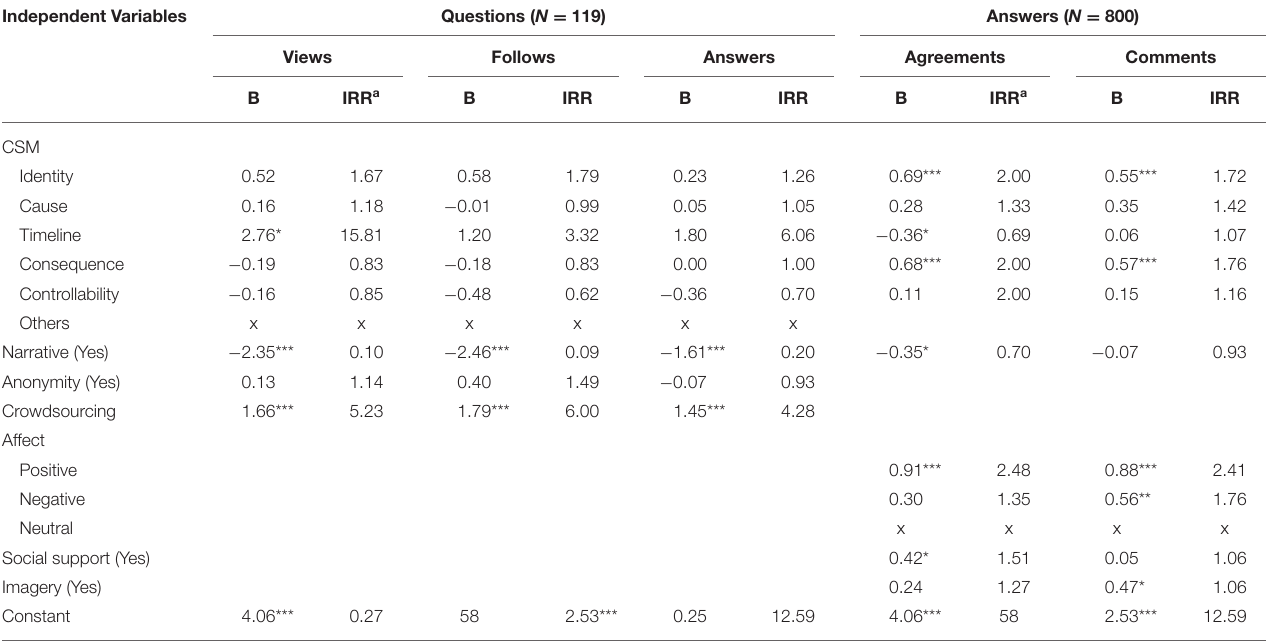
TABLE 2 | Negative binomial regression on user engagement in questions and answers as functions of message features. Independent